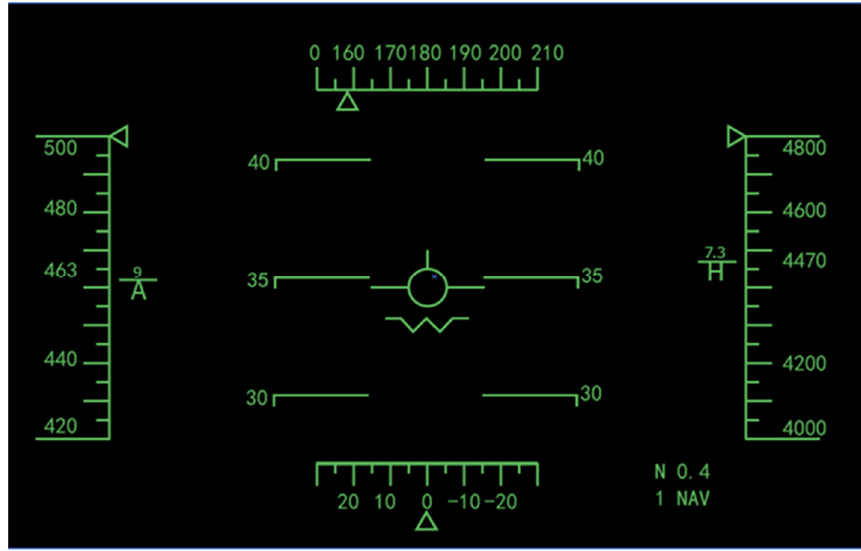
Figure 4. The simulation flight interface.